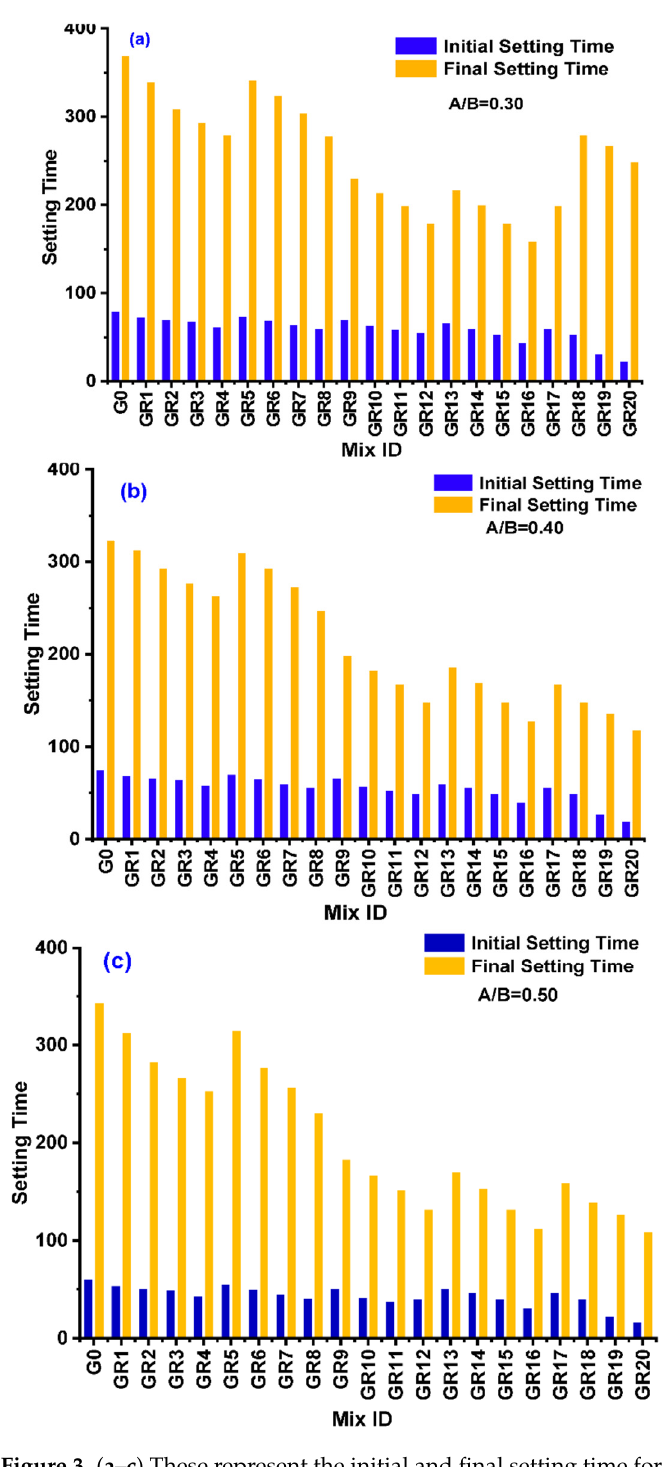
Figure 3. ( a – c ) These represent the initial and final setting time for A/B ratio of 0.3, 0.4, and 0.5 for various mixes of GPC. various mixes of